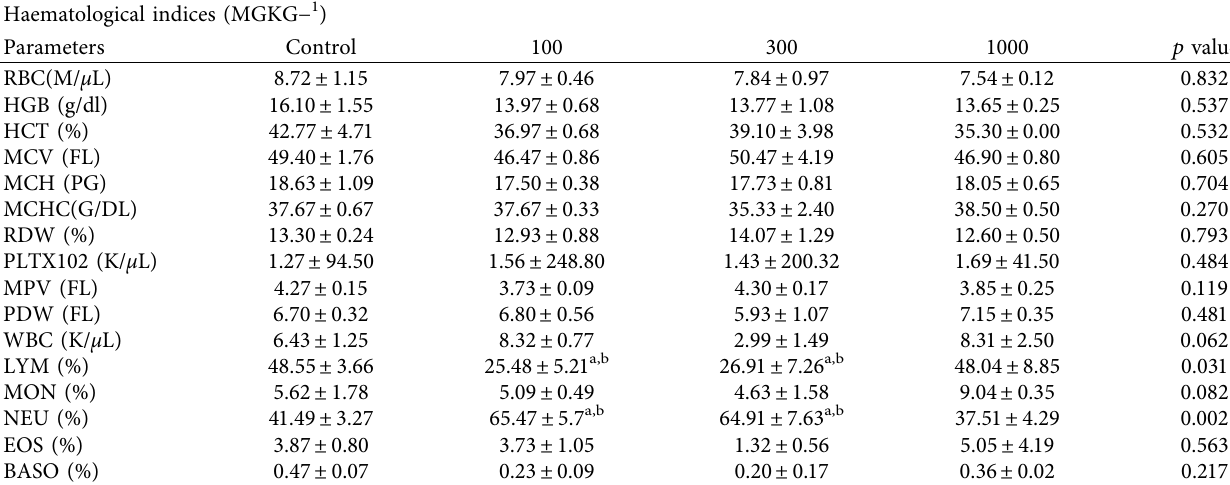
Table 1: Haematological indices in animals orally treated with the AAE in the subacute toxicity tests. Haematological indices (MGKG − 1